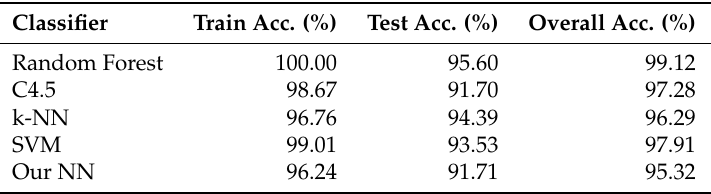
Table 7. Comparison of accuracy for different